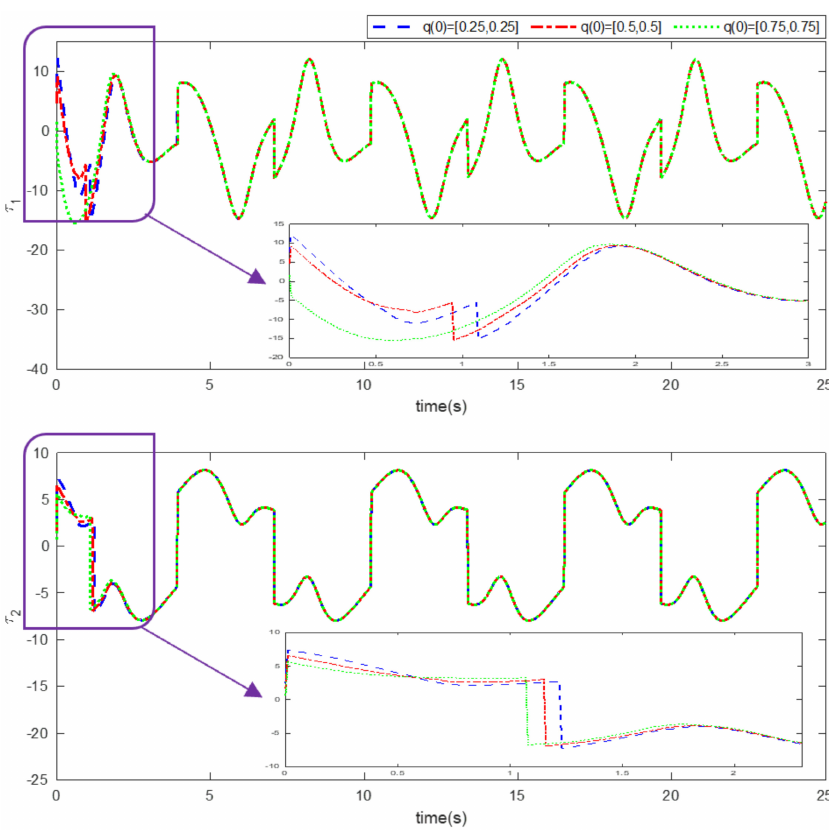
Figure 7. Control inputs (Example 1).